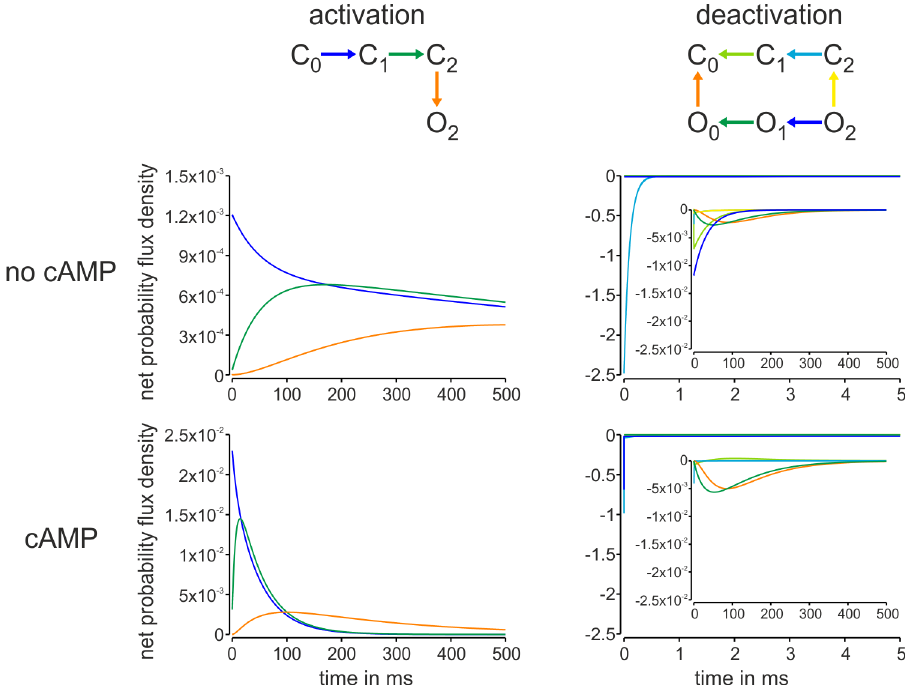
Fig 4. Effect of cAMP on the probability flux densities along the main pathways of activation from 0 mV to -130 mV and subsequent deactivation to -40 mV. The time courses were computed with model 1 n (no cAMP) or 1 a (10 μM cAMP). The colors of the arrows in the top schemes correspond to the colors of the probability flux density time courses. The predominant effect of cAMP is to strongly accelerate the probability flux density of the activation